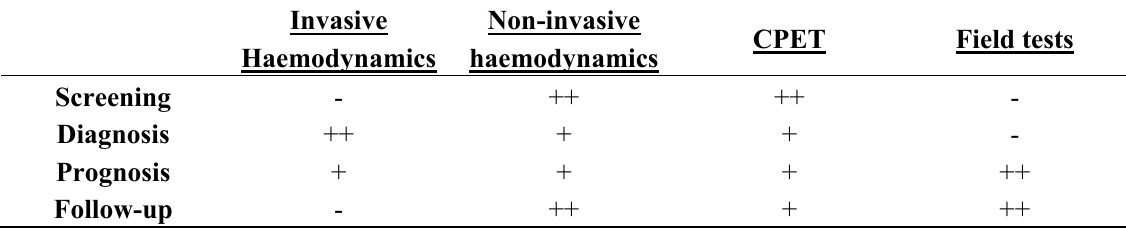
Table 4. Likely future Indications for exercise testing modalities in management of